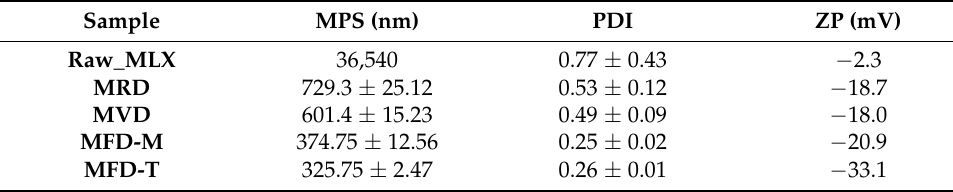
Table 2. MPS, PDI, and ZP of MLX nanocrystals after redistribution in